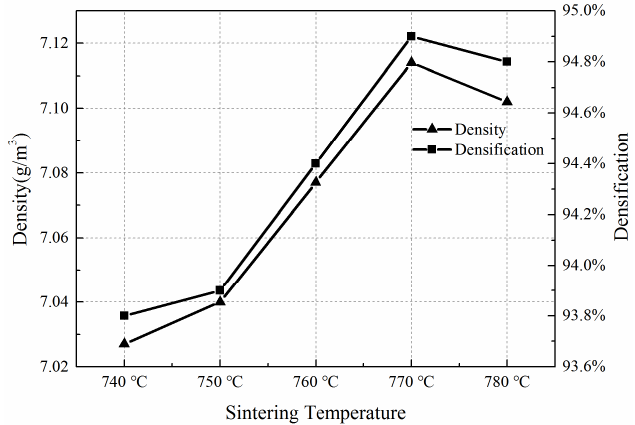
Figure 6. Density and compactness of AD/Cu-Fe sandwich composite material.